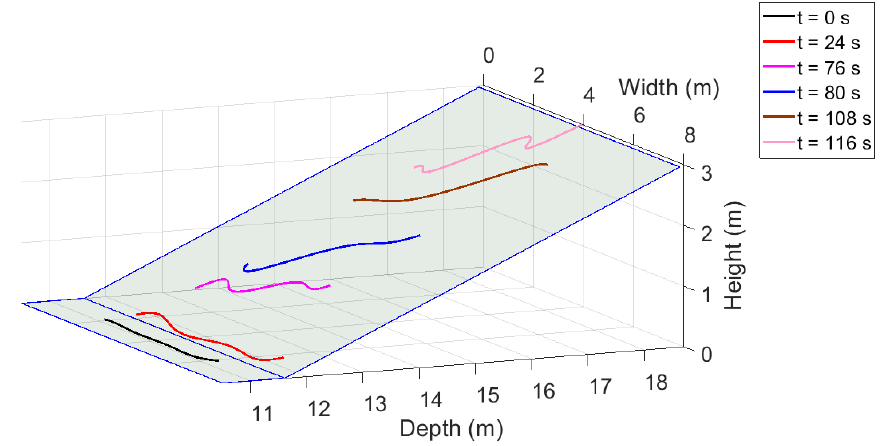
Figure 32. Temporal evolution of the fire position at given